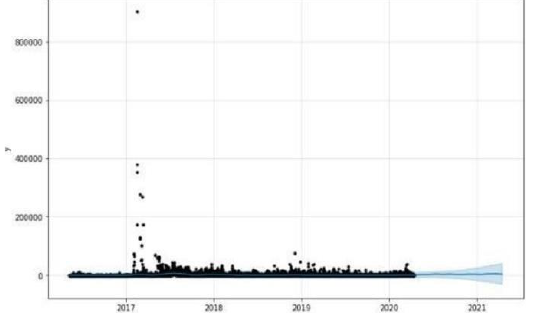
Fig 17. Prophet API prediction of Ether prices.